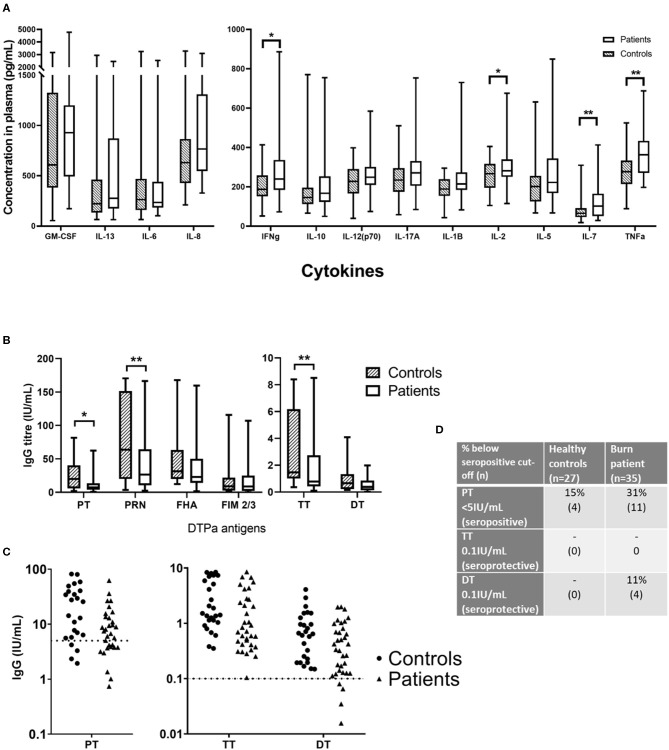
Concentrations of circulating cytokines and vaccine-specific IgG in plasma of burn survivors and controls. A multiplex cytokine assay was used to measure the concentration of 13 cytokines, and IgG targeting six antigens from the diphtheria, tetanus acellular pertussis (DTPa) vaccine. (A) Mann-Whitney tests used to compare burn survivors and controls (n = 36 age/sex-matched pairs) demonstrated four cytokines were elevated in burn survivors: interferon gamma, IL-2, IL-7, and tumor necrosis factor alpha. (B) IgG concentrations specific for pertussis toxin, pertactin, and tetanus toxin were lower in burn survivors; (C) dotted lines indicate thresholds of seropositivity (PT > 5 IU/mL, and long term seroprotection against tetanus and diphtheria (TT and DT IgG > 0.1IU/mL). (D) The rates of seropositivity/seroprotection in the burns cohort (n = 35) for pertussis toxin, tetanus toxin and diphtheria toxoid, compared to controls (n = 27). Experiments were performed in duplicate and the average used for analysis. **p < 0.01, *p < 0.05. GM-CSF, granulocyte-macrophage colony-stimulating factor; IL, interleukin; IFNg, interferon gamma; TNFa, tumor necrosis factor alpha; PT, pertussis toxin; PRN, pertactin; FHA, filamentous hemagglutinin; FIM 2/3, fimbriae types 2/3; TT, tetanus toxin; DT, diphtheria toxoid.